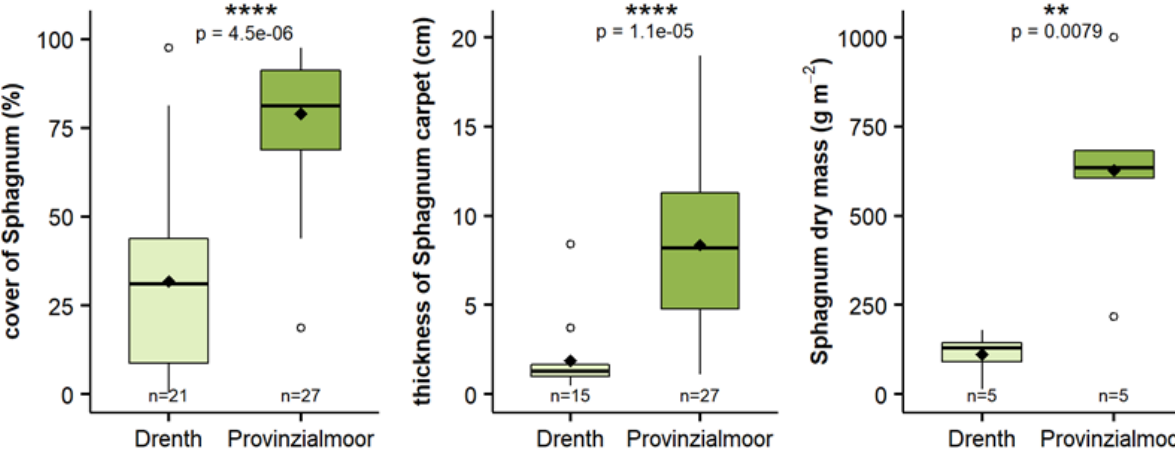
Figure 7. Comparison of the establishment of Sphagnum palustre on the study sites Drenth and Provinzialmoor in cover (%), carpet thickness (cm) and dry mass (g m -2 ) in September 2018 (including only data from sections where straw was used as protective cover). Carpet thickness includes only measured values where mosses were present. Boxplots are showing median (central thick lines), 25 % and 75 % quartile ranges around the median (box length), outliers (circles) and mean values (rhomb); stars indicate the level of significance; n: number of samples.